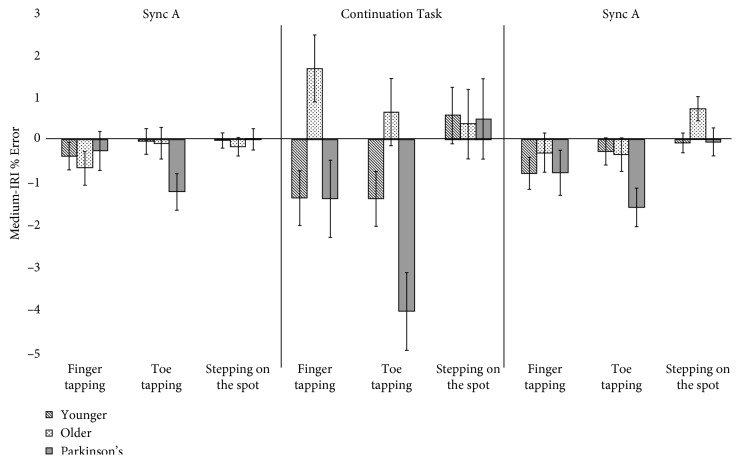
The significant main effect of movement modality on entrainment ability (IRI % Error) and the significant interaction between groups in the medium tempo. Y-axis shows IRI % Error. X-axis shows the temporal nature of the experimental paradigm.